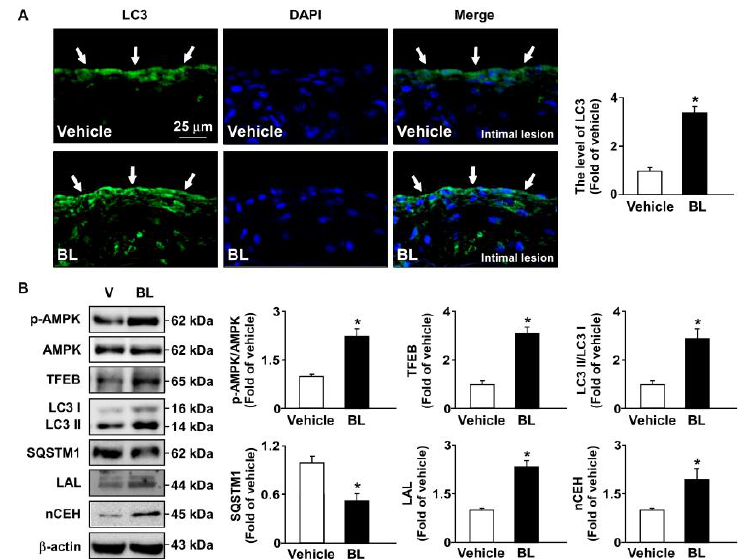
Figure 7. Bromelain activates autophagy in the aortas of apoe −/− mice . Male apoe −/− mice were orally administered bromelain (BL, 20 mg/kg/day) or vehicle (PBS) for four weeks. ( A ) Immunostaining with anti-LC3 antibody in aortas of bromelain- or vehicle-treated apoe − / − mice. Scale bar = 25 µ m. The vascular cells with LC3 positive signals were indicated by arrows. ( B ) Western blot analysis of p-AMPK, AMPK, TFEB, LC3, SQSTM1, LAL, nCEH, and β -actin. * p < 0.05 vs. vehicle-treated apoe − / −